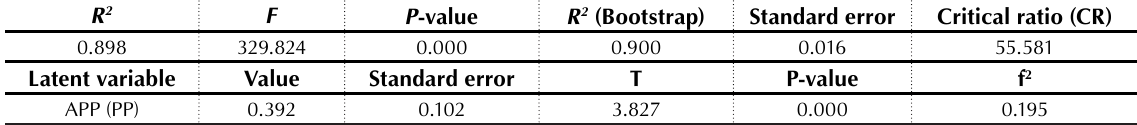
Table 9. Direct impact of PP on TA R